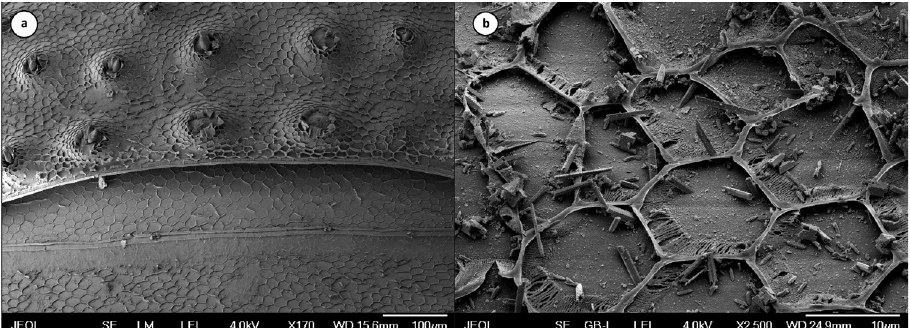
Figure 9. First and second pereionites of M . g . graniger showing the position of tubercles ( a ); detail of the honeycomb-like net of scales at M . g . dragani ( b ) (after Giurginca et al. 2012